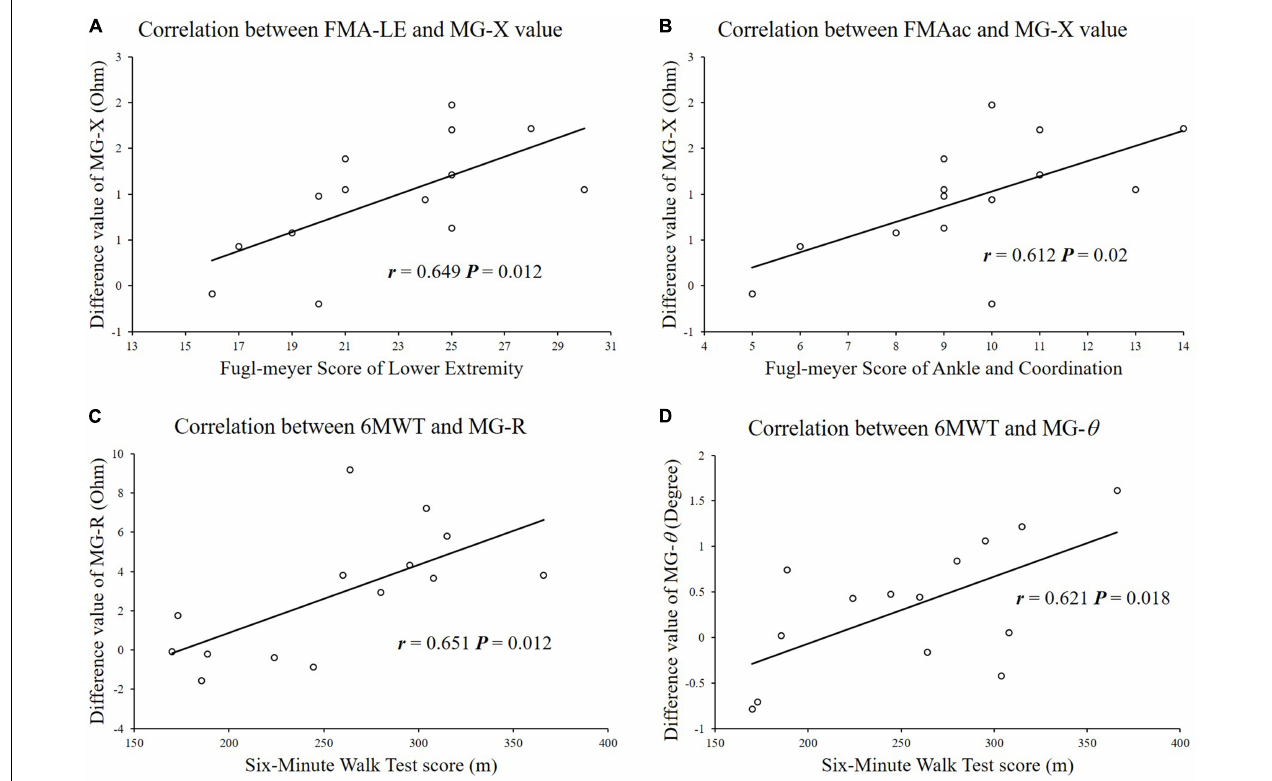
FIGURE 3 | Correlation analysis between impedance parameters and functional clinical scale scores. (A) FMA-LE scores were significantly correlated with difference of reactance values in MG. (B) FMAac scores were significantly correlated with difference of reactance values in MG. (C) 6MWT scores were significantly correlated with difference of resistance values in MG. (D) 6MWT scores were significantly correlated with difference of reactance values in